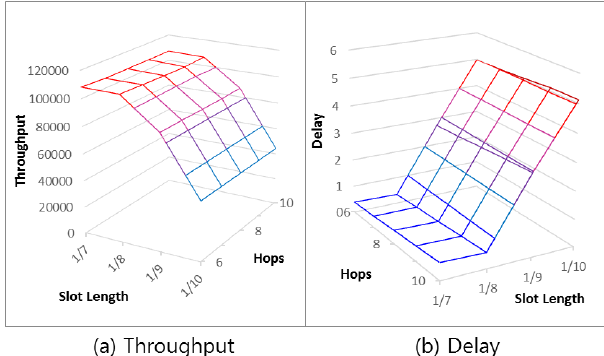
Figure 4. Throughputs and delays varying the slot length and hop